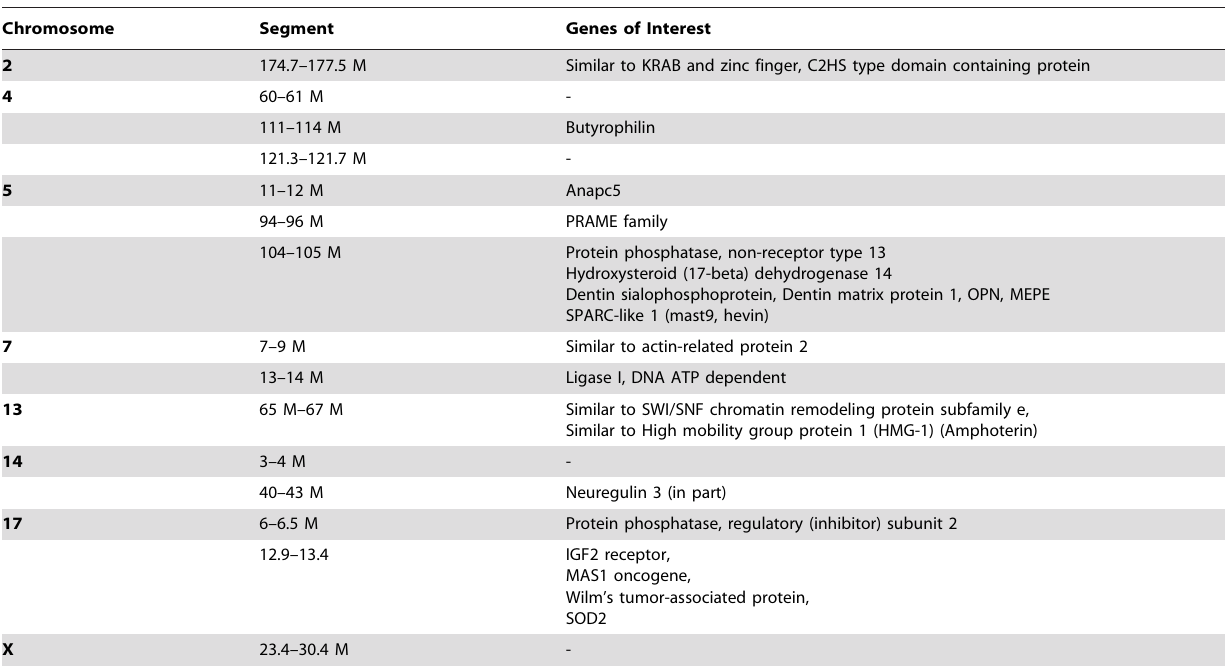
Table 2. Genes of interest on chromosomal